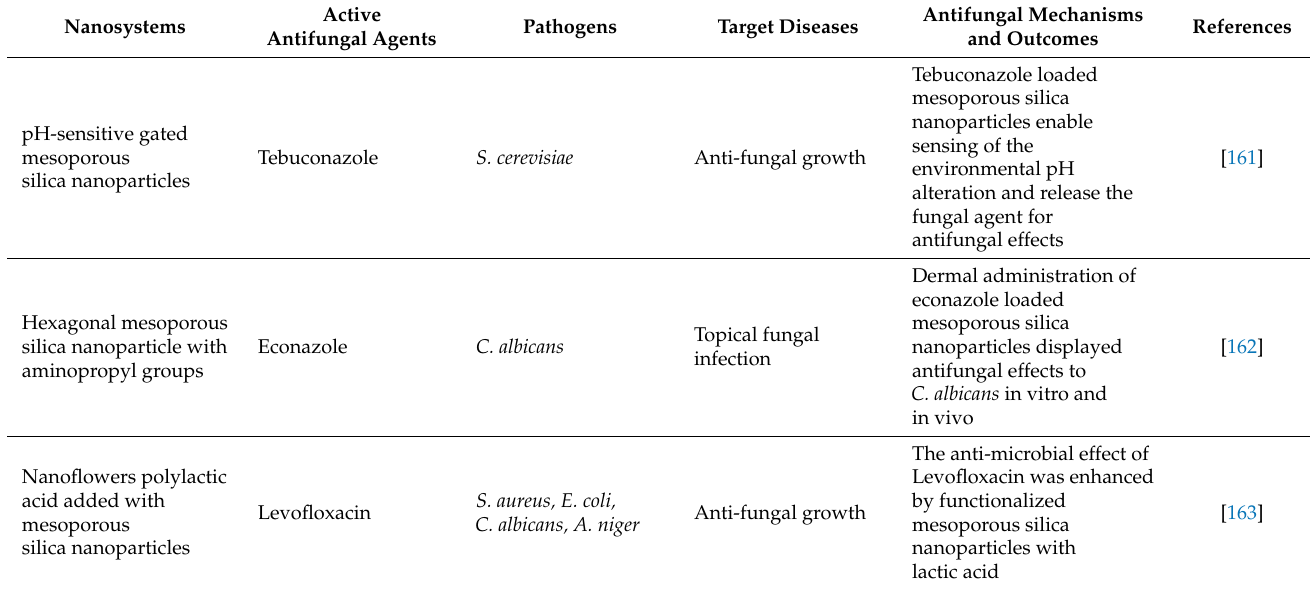
Table 4. Mesoporous Silica Nanoparticle based antifungal therapeutic